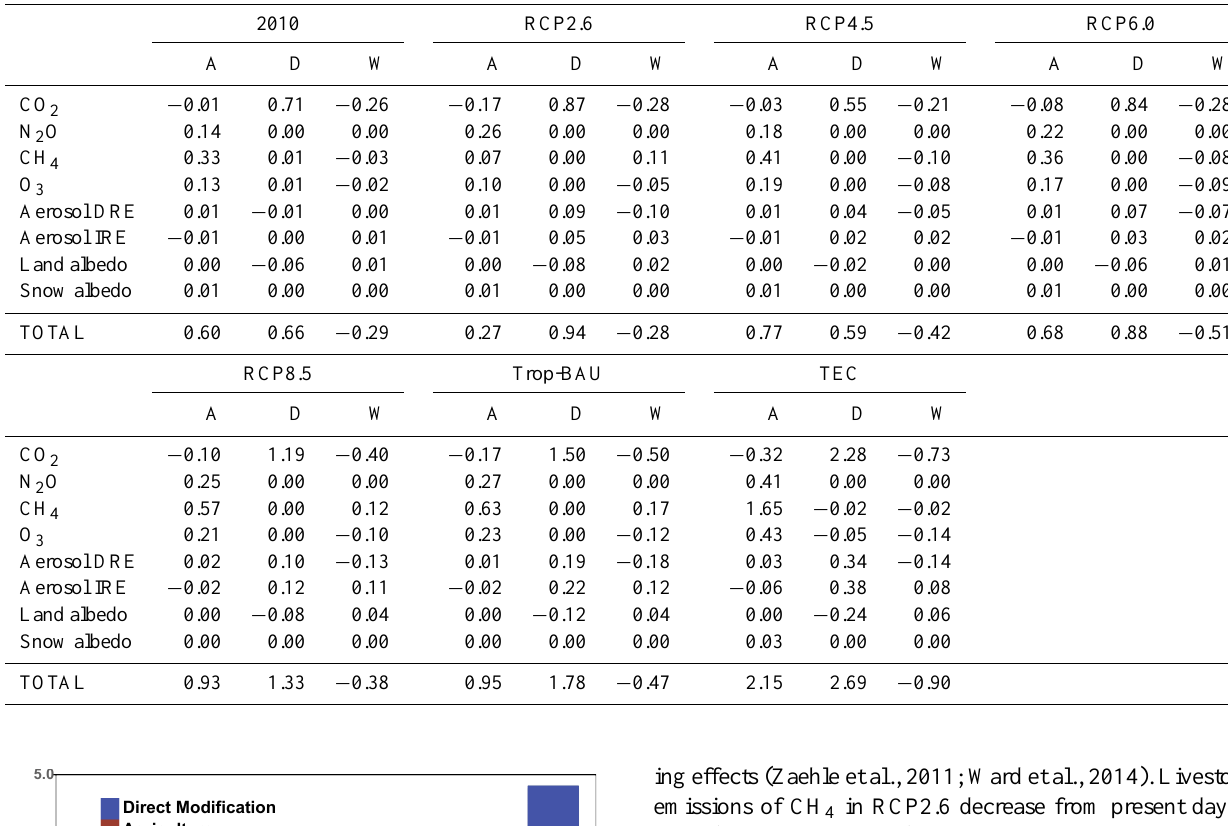
Table 1. RF values (Wm − 2 ) for each sector, direct modifications to land cover (D), agriculture (A), and the wildfire response (W) for year 2010, and for the year 2100 given each of the six future scenarios used in this study.